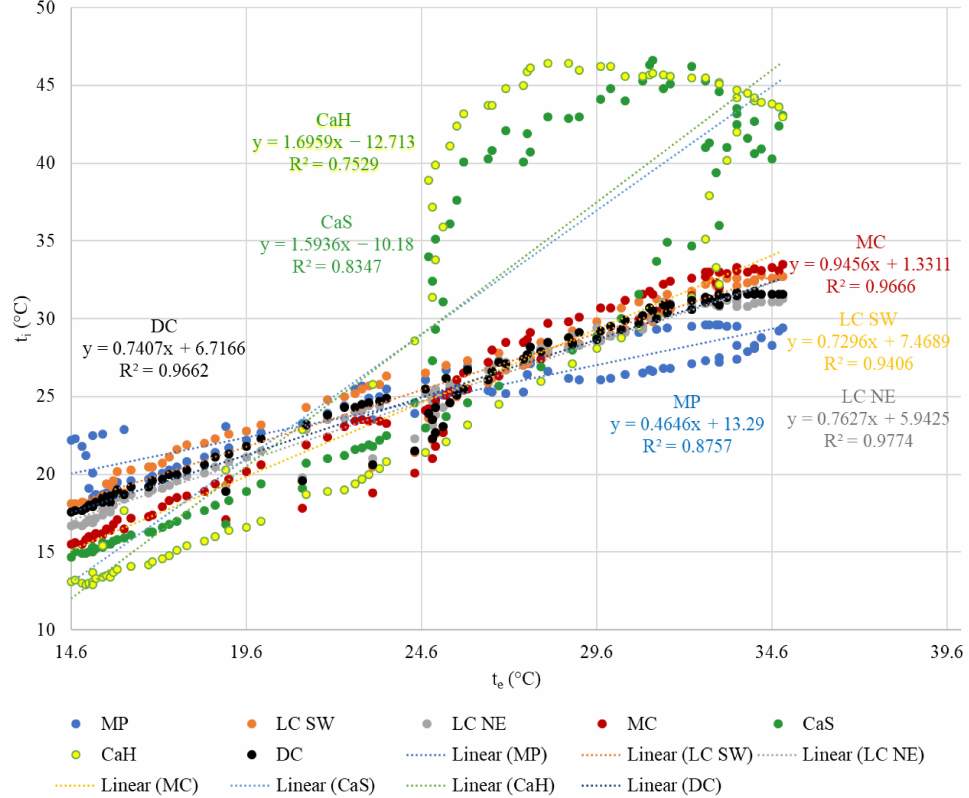
Figure 7. The dependence of the indoor air temperature on the outdoor air temperature during the hot summer